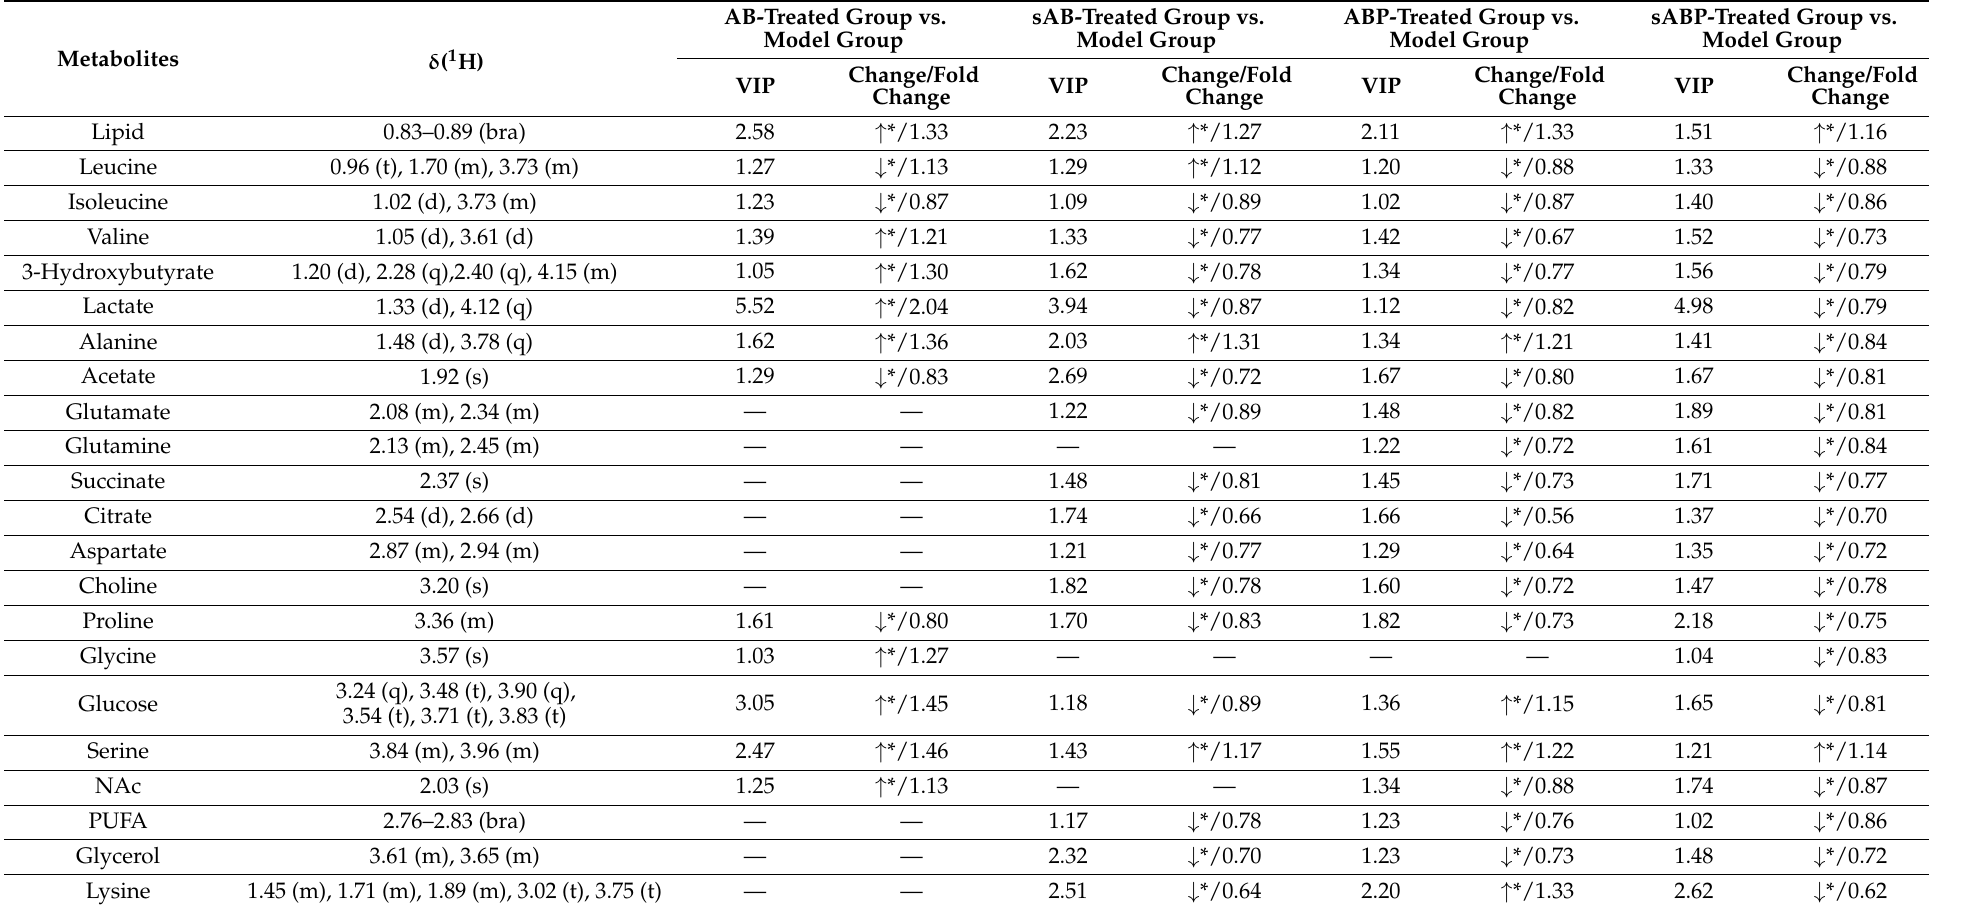
Table 4. Changes in relative levels of metabolites in the serum samples from different